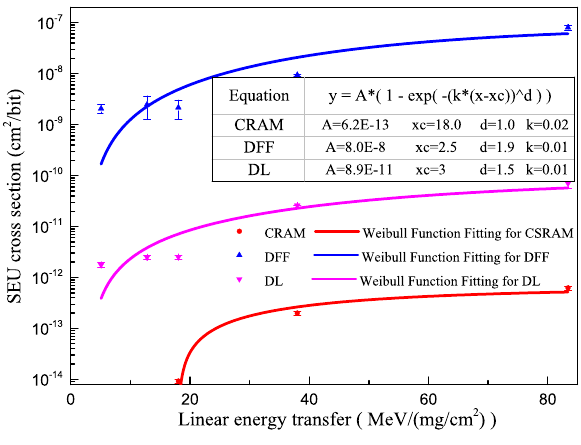
Figure 7. SEU cross section in CRAM, DFF and DL vs. LET.